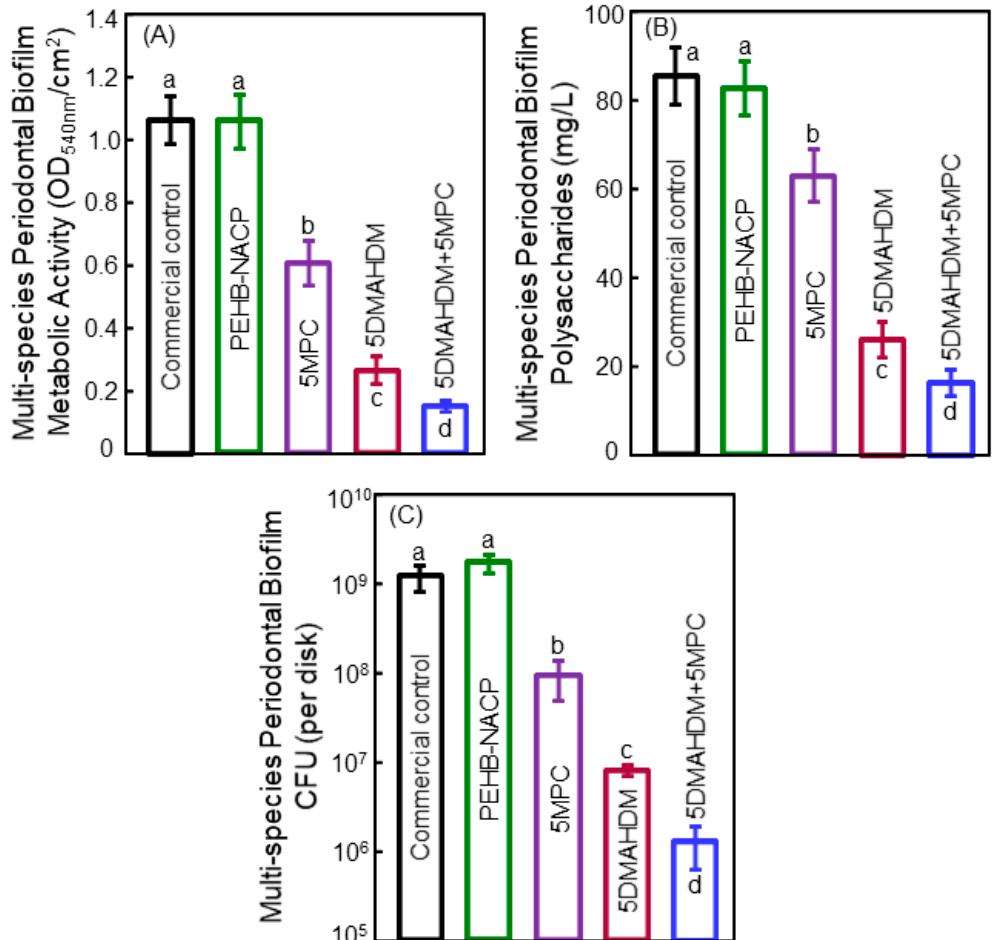
Figure 7. Multi-species periodontal biofilm: ( A ) metabolic activities, ( B ) polysaccharides production, and ( C ) CFU values on different dental bonding adhesive disks (mean ± SD; n = 6). The y -axis has the log scale in plot ( C ). Values indicated by dissimilar letters are significantly different from each other ( p < 0.05). Adapted from [84], with permission from © 2017 RSC Advance.